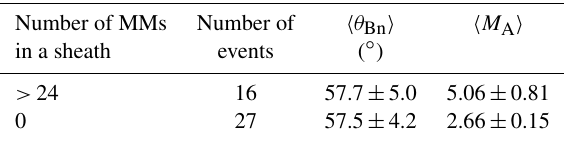
Table 5. The averages of the shock parameters of the ICME-driven sheaths that had more than 24 MMs and that did not have any MMs. The errors are defined by